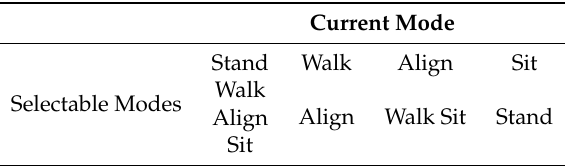
Table 1. List of selectable modes in each physical